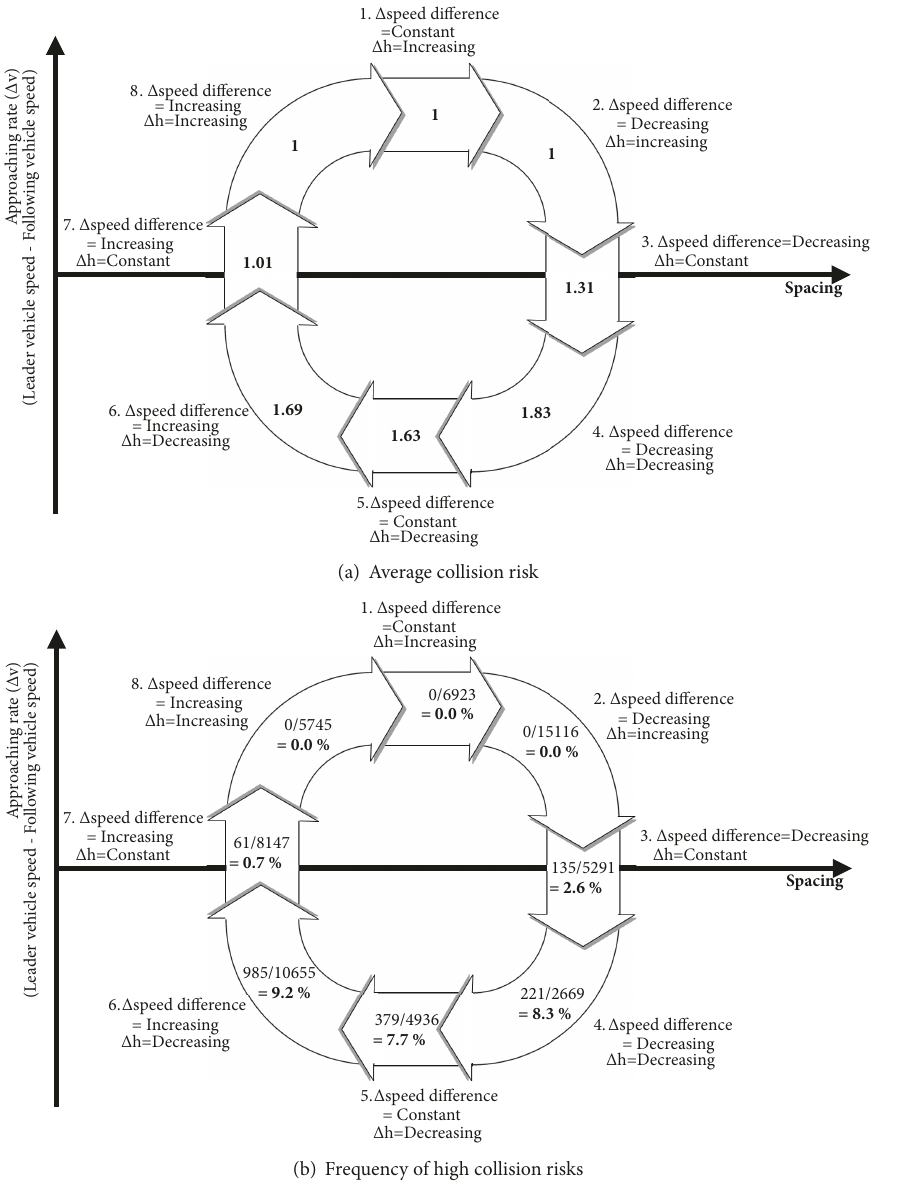
Figure 6: The TTC trends on the average collision risk and frequency of high collision